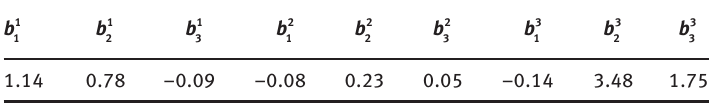
Table 2. Coefficients of the Matrix B ( × 10 –3 ).